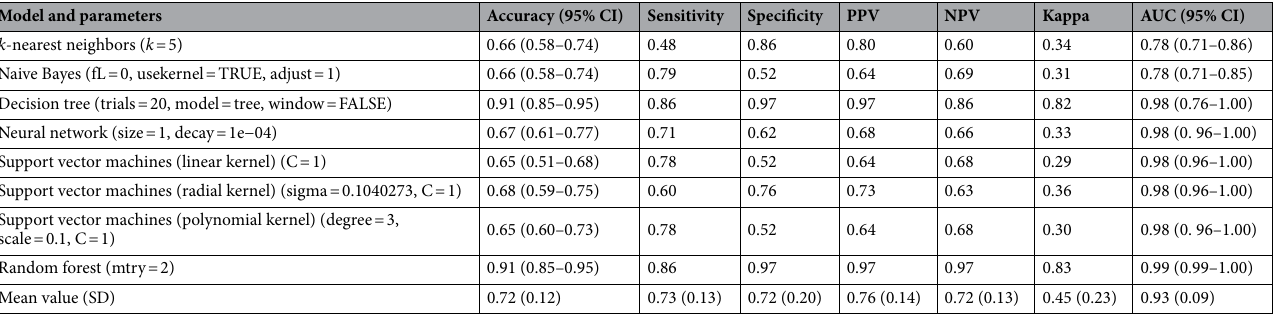
Table 2. Prediction accuracy of the electronic nose in the test set of machine learning algorithms. PPV positive predictive value, NPV negative predictive value, AUC area under the receiver operating curve.